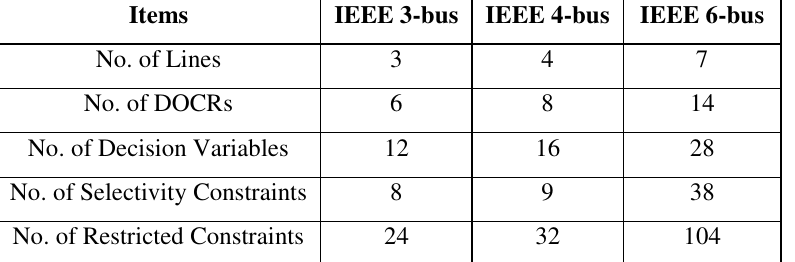
TABLE 4: PARAMETER SETTINGS OF THREE CASE STUDIES IN DOCRs PROBLEMS.